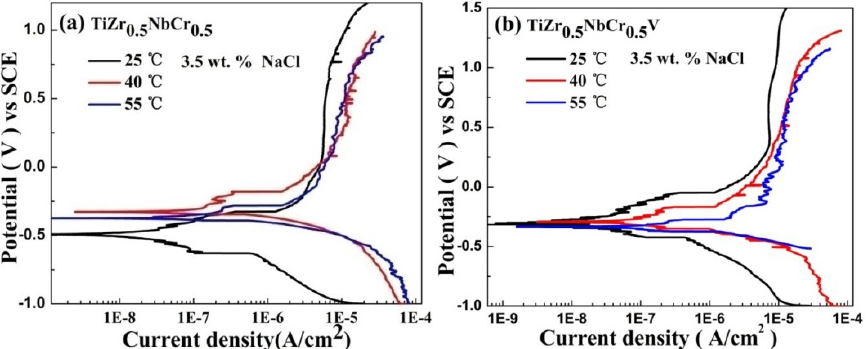
Figure 4. Polarization diagrams